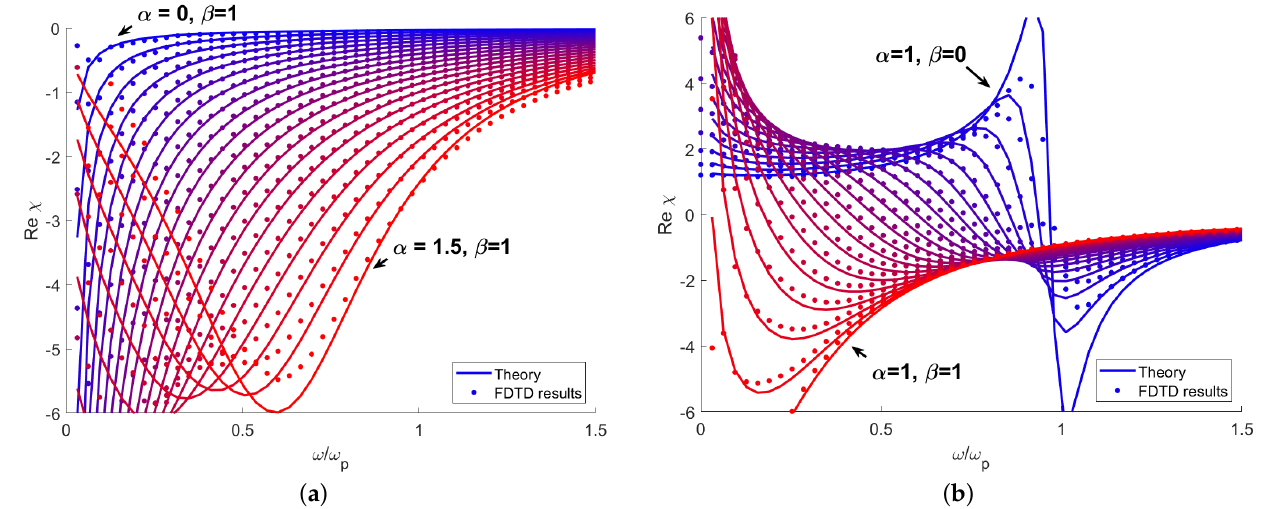
Figure 1. Real part of susceptibility calculated analytically from (5) and numerically for various values of ( a ) α and ( b ) β